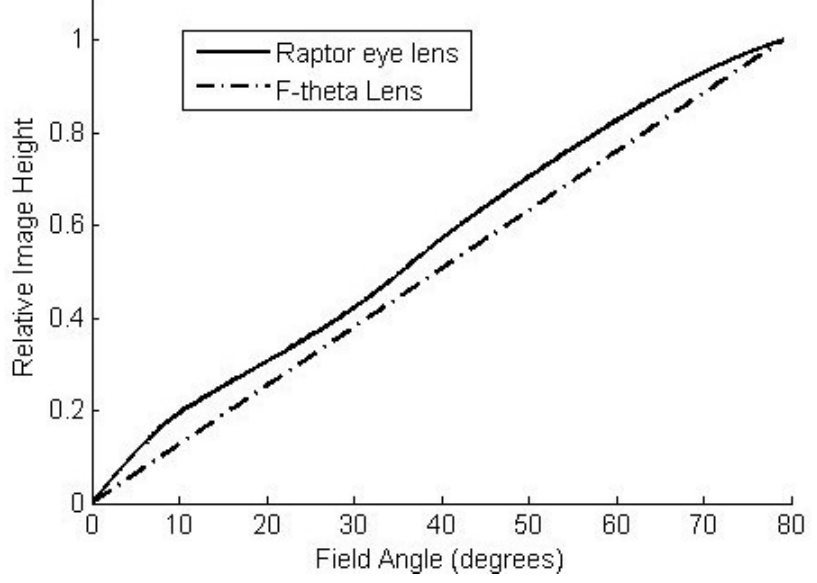
Figure 4. Modeled raptor eye projection compared to an F-theta model, displayed as image height vs. field angle.